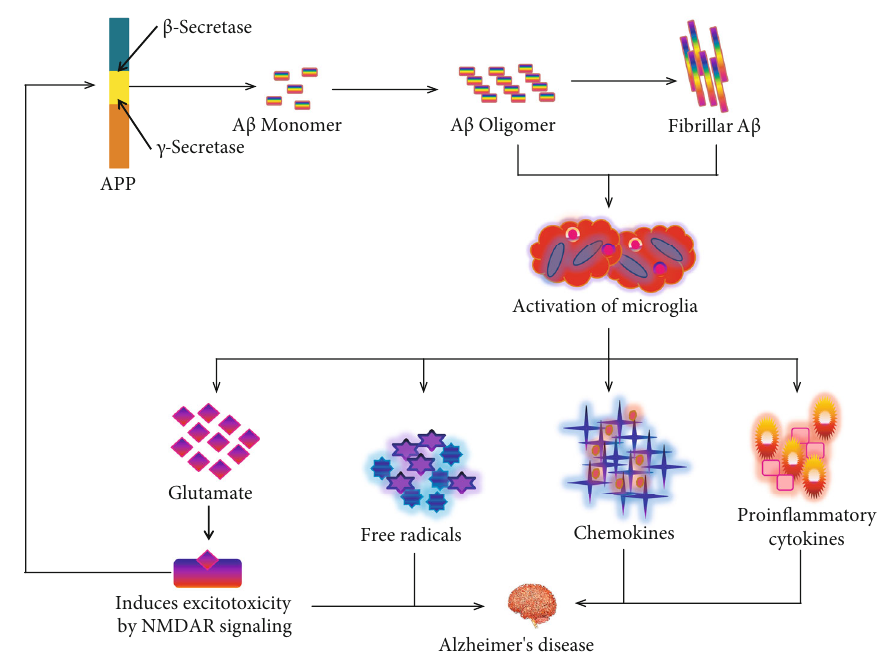
Figure 1: Role of A β in the activation of microglia to initiate Alzheimer ’ s pathology. A β : amyloid beta; APP: amyloid precursor protein; IL-1: interleukin-1; IL-6: interleukin-6; TNF- α : tumor necrosis factor- α ; MCP-1: monocyte chemotactic-1; MIP-1: macrophage in fl ammatory protein-1; HO: hydroxyl radical; H